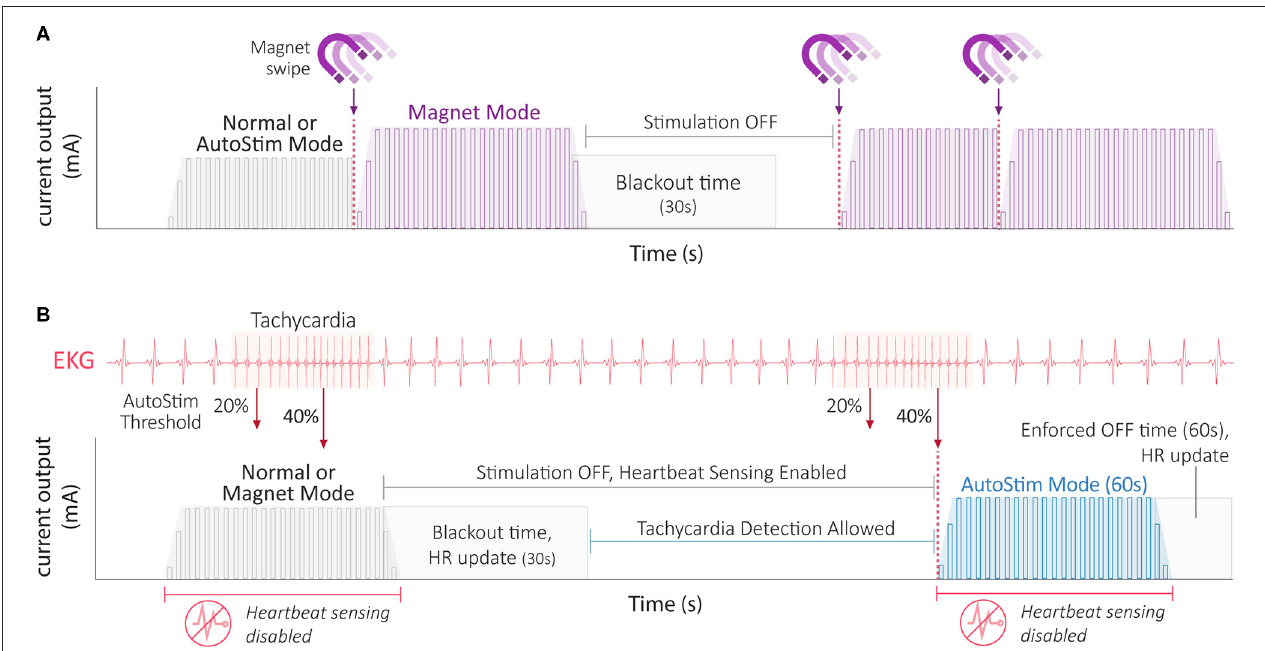
FIGURE 5 | VNS Therapy stimulation mode interactions. (A) Interaction amongst stimulation modes during a therapy magnet swipe (purple icon). A magnet swipe interrupts both Normal Mode and AutoStim Mode stimulation (left). A magnet swipe during a Magnet Mode stimulation effectively resets the Magnet Mode stimulation period (right). Note the stimulation blackout time of 30s to prevent overstimulation. (B) Interaction of stimulation modes with respect to tachycardia-triggered AutoStim Mode. Detected tachycardic events at varying AutoStim thresholds are shown superimposed upon an EKG trace. Because heartbeat sensing is disabled during a stimulation event, AutoStim Mode stimulation is not possible despite the heart rate surpassing the set AutoStim threshold (e.g., 40%). The Tachycardia Detection Algorithm is updated with heart rate information for 30s after stimulation. Also note the stimulation blackout time of 30s to prevent overstimulation where AutoStims cannot occur. Tachycardia detection, and therefore AutoStim is allowed after the blackout period. When a patient’s relative heart rate surpasses the set AutoStim threshold (e.g., 40%) during an allowable time, AutoStim is triggered (right). Following an AutoStim event, an ‘enforced OFF time’ equal to the length of the AutoStim event ensures a ≤ 50% duty cycle. Note that AutoStim Mode is only available on M106, M1000 and M1000-D generators. AutoStim, autostimulation; EKG, electrocardiogram; HR, heart